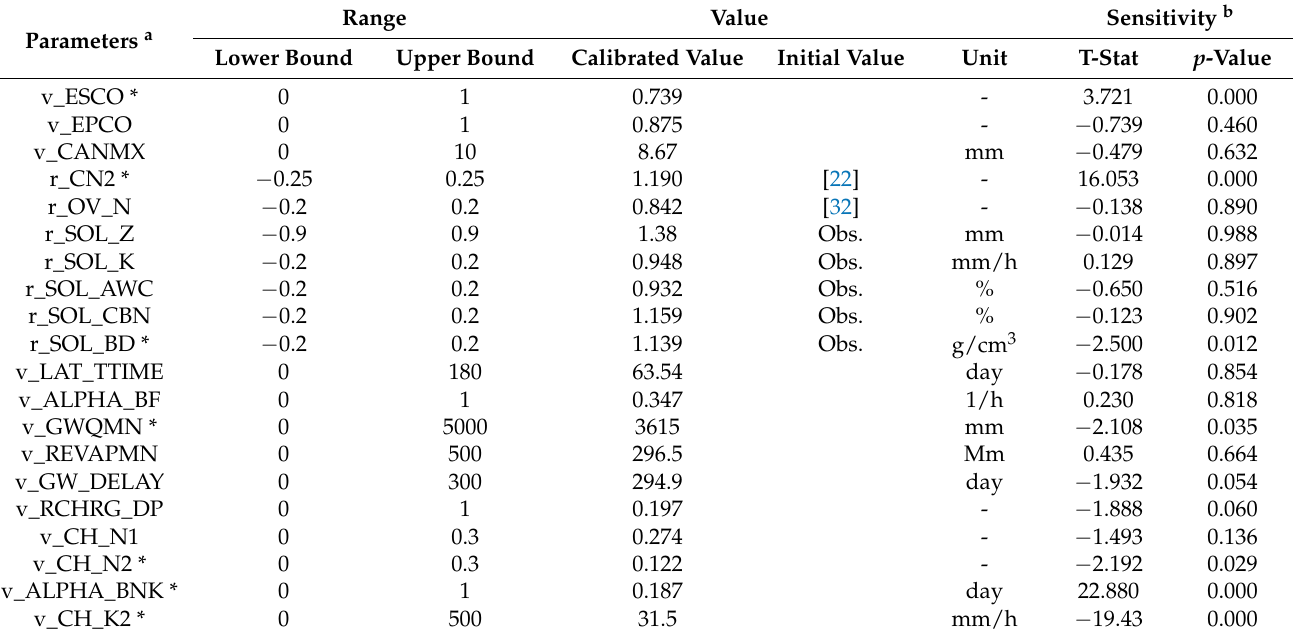
Table 4. SWAT calibrated parameters with their range and best-fit